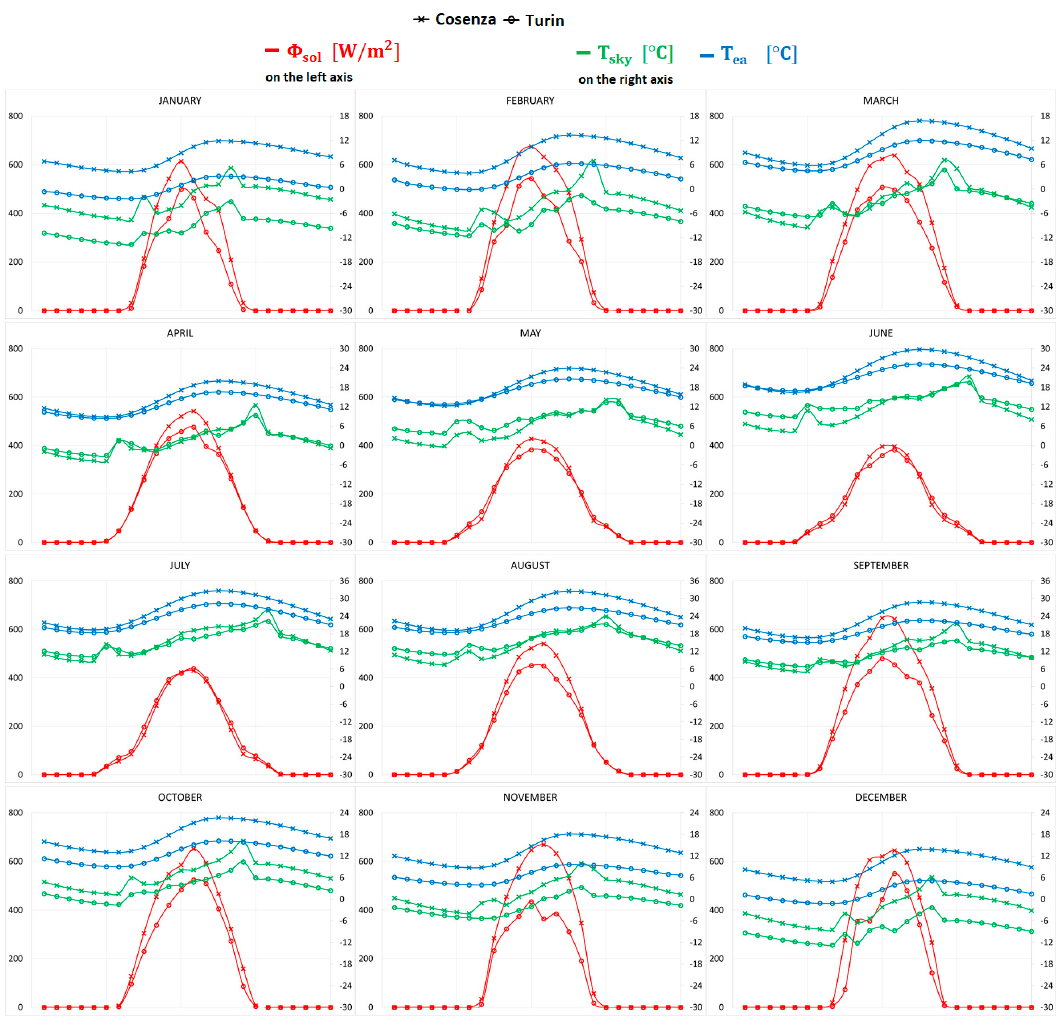
Figure 3. Characteristic day of the different months in Cosenza and Turin. In each image: incident solar radiation on the vertical plane exposed to South Φ sol on the left axis, and sky temperature T sky and external air temperature T ea on the right